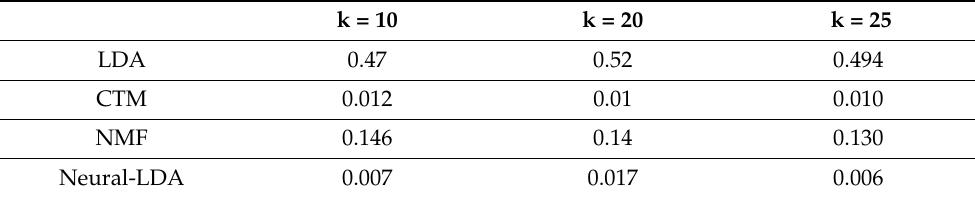
Table 5. Similarity results.